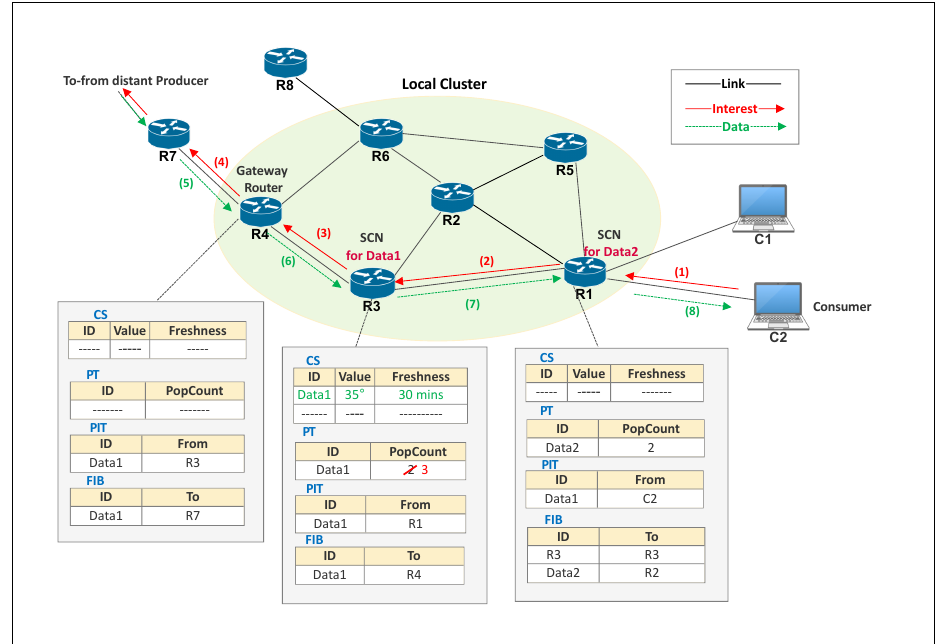
Figure 2. PF-ClusterCache: Data content retrieval from the producer.